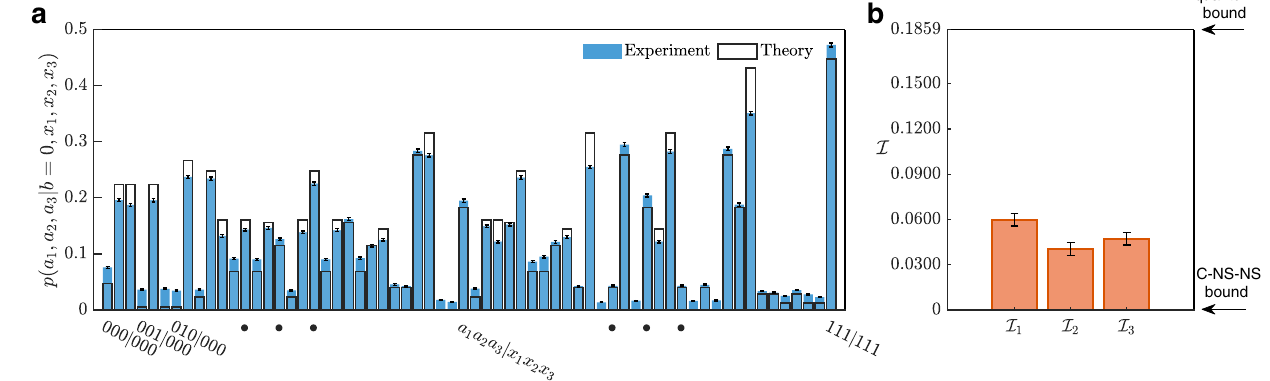
network nonlocality. The theoretical maximum value is equal to 0.1859 (the quantum bound) for all inequalities. The error bars represent one standard devia- tion and are deduced from the photon statistical error of the raw data.